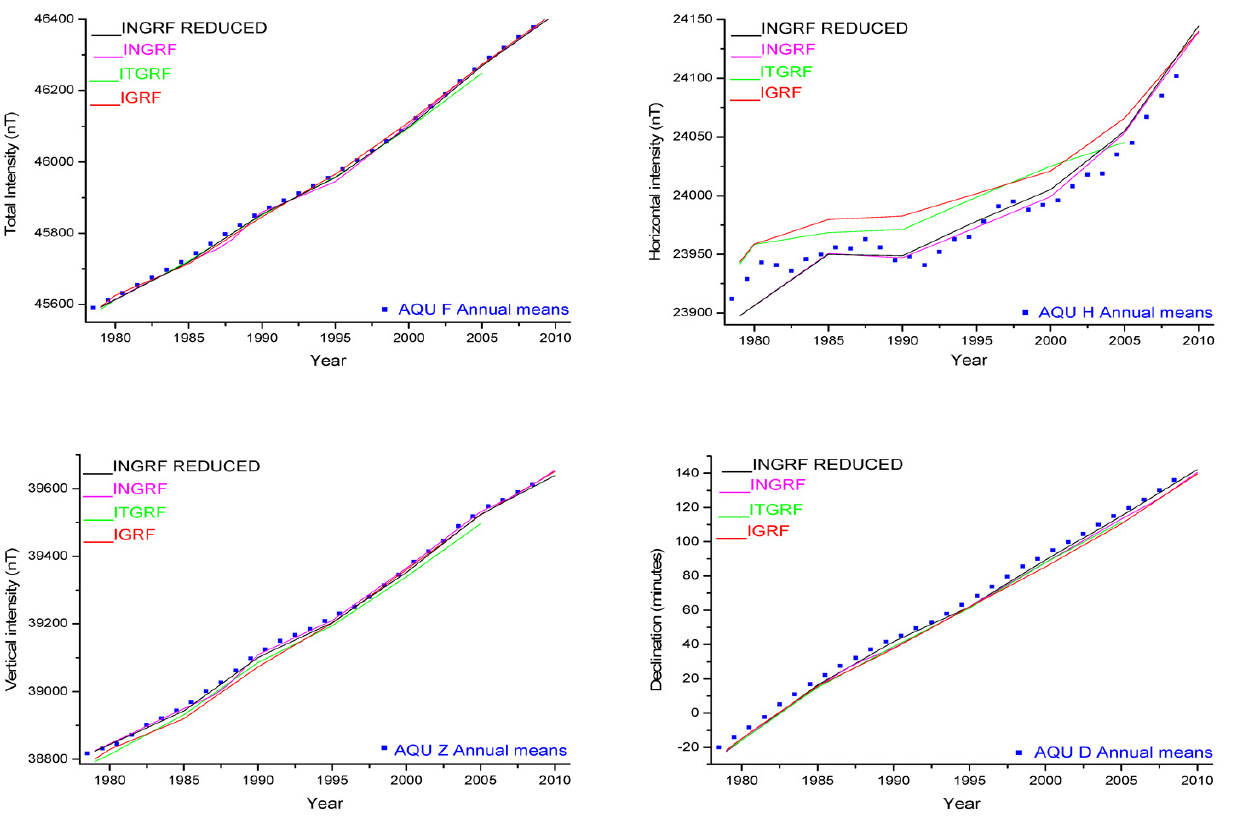
Figure 8. Annual mean values of F, H, Z, D computed at L'Aquila observatory (squares) together with the values predicted by various models (coloured